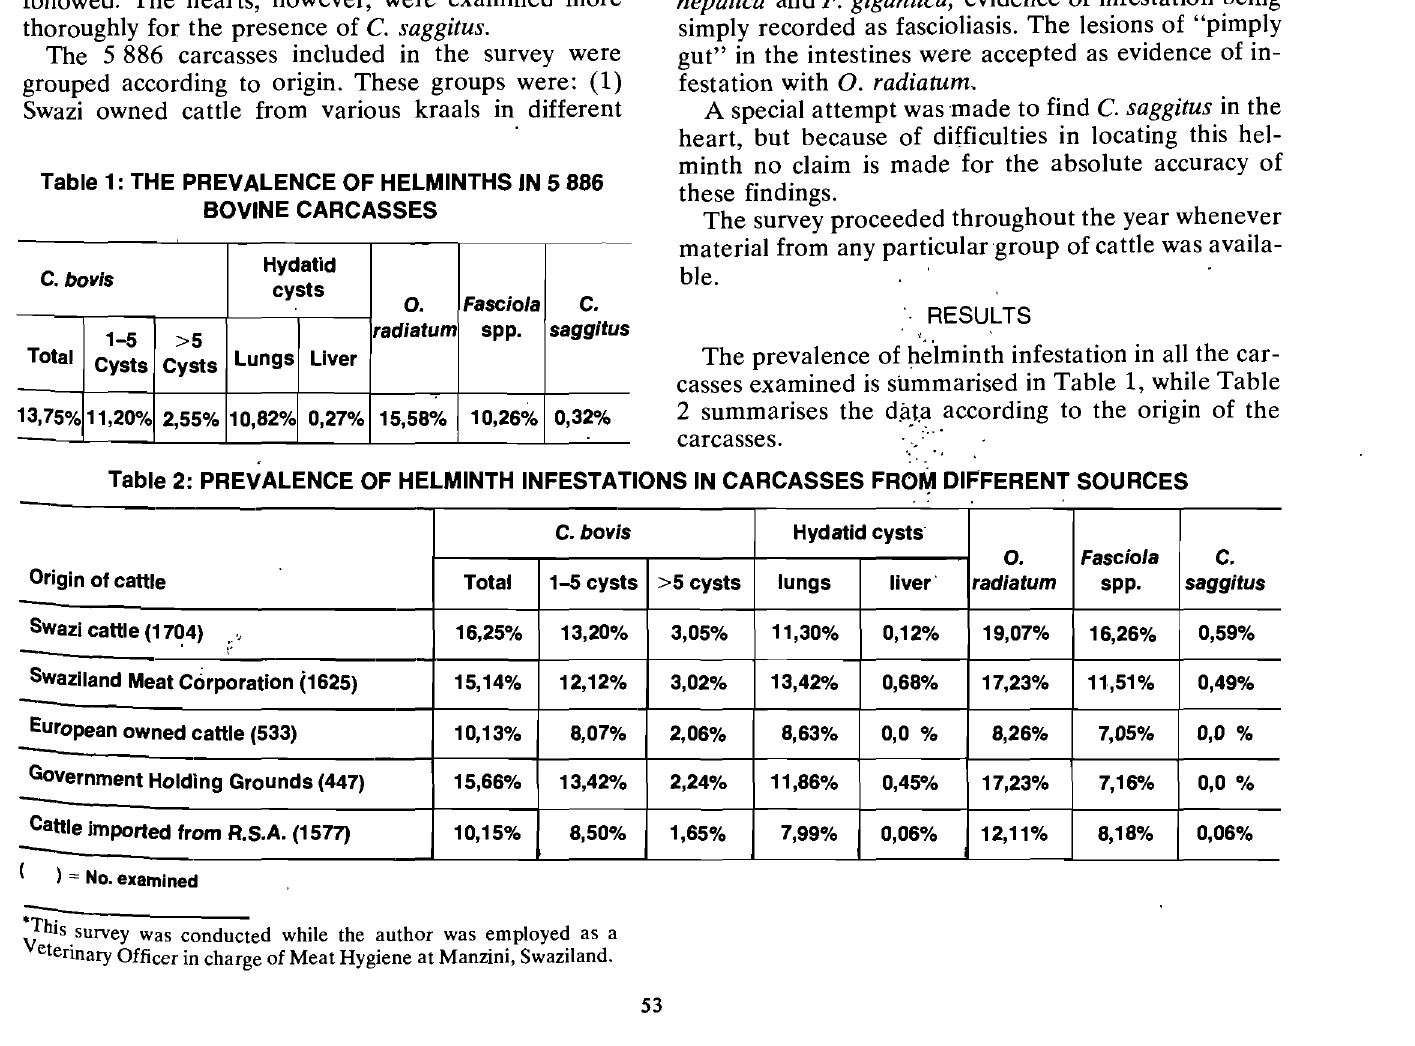
Table 1: THE PREVALENCE OF HELMINTHS IN 5 886 BOVINE CARCASSES